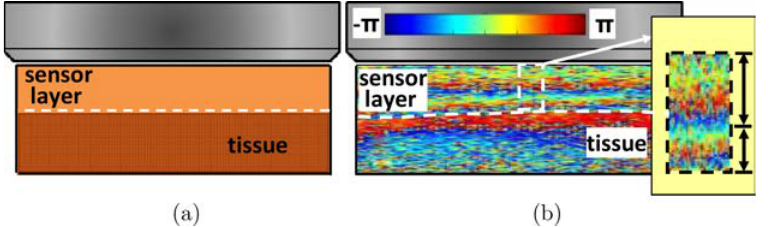
Fig. 1. The use of independently-calibrated sensor layer to study underlying tissue in compressional OCE, and associated real-life artefacts. (a) idealized plane-parallel geometry showing the compressional probe, sensor layer, and interrogated tissue that can freely expand laterally; (b) an experimental example of interframe OCE phase distribution, with the dashed line showing the actual interface between the sensor layer (homogeneous silicone) and tissue (tumor inoculated in the mouse ear); the inset zooms in on a region of phase gradient heterogeneity in the homogeneous sensor layer caused by its partial sticking to the OCT